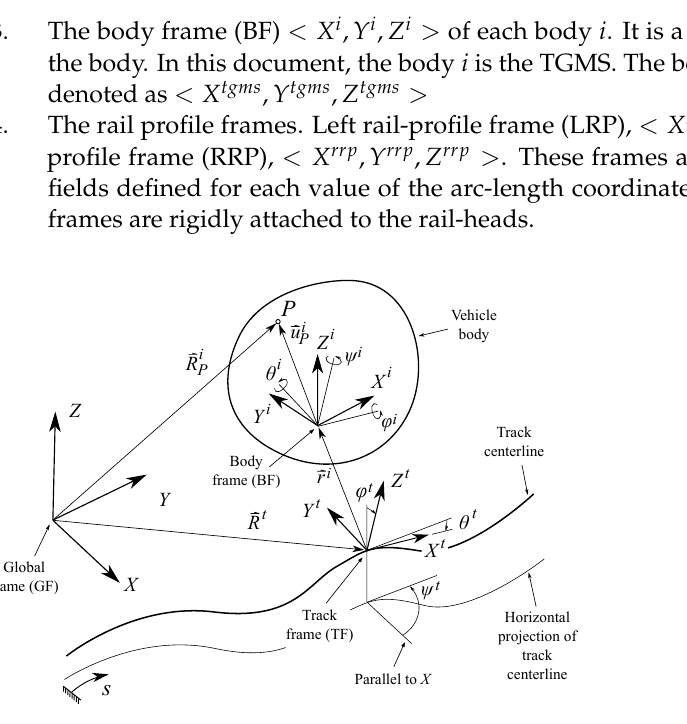
Figure 2. Kinematics of a body moving along the track. The definition of the TF is such that the X t axis is tangent to the track design centerline, the Y t axis is perpendicular to X t and connects the origin O lrp of the LRP and the origin O rrp of the RRP in the design track geometry (with no track irregularities) and the Z t axis is perpendicular to both X t and Y t . Therefore, the TF is not the Frenet frame of the design track centerline. Each body i moving along the track has an associated TF at each instant of time. Its position and orientation can be obtained substituting the position of the body along the track, s i ( t ) , in the functions R t ( s ) and A t ( s ) that are explained in next section. More details about the rail kinematics and the nomenclature used in this work for vectors and rotation matrices can be found in [17].